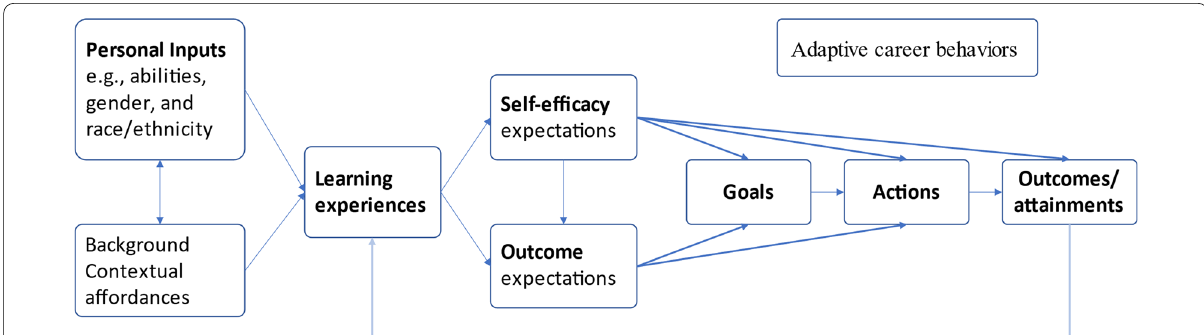
Fig. 1 The SCCT model of Career Self‑Management—CSM (adapted from: Lent & Brown,